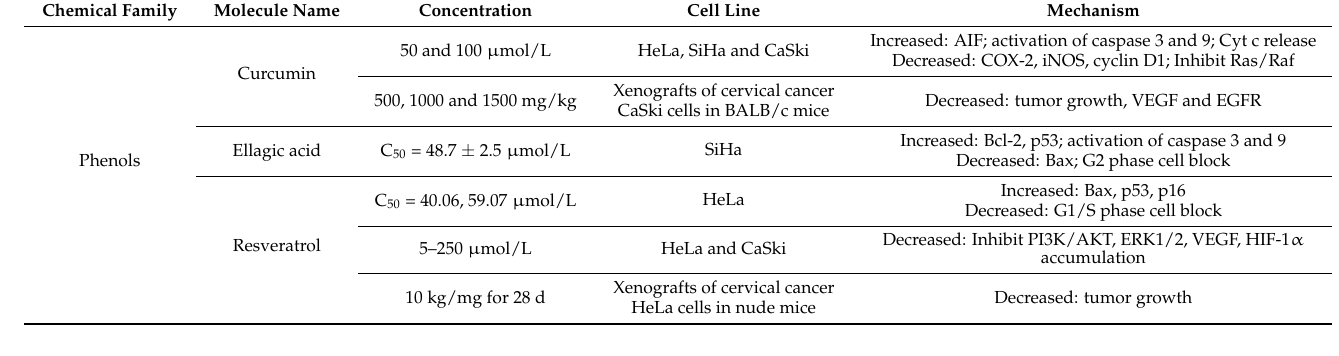
Figure 4. Chemical structure of several phenols against cervical cancer. Table 4. Effect of phenols on cervical cancer.